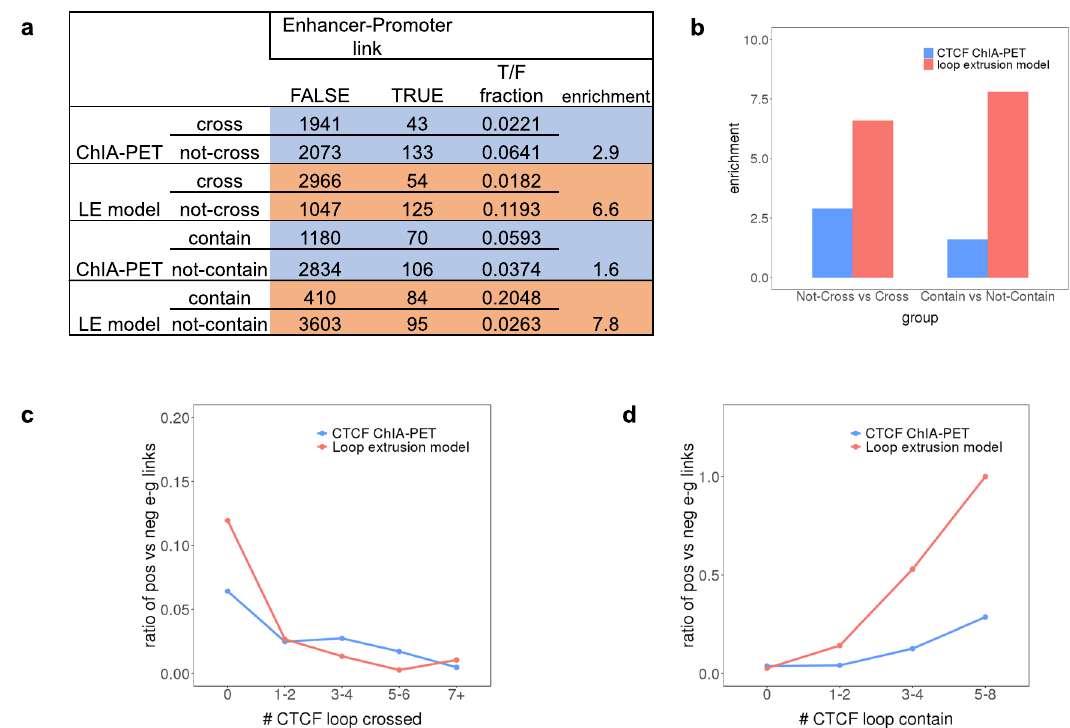
Fig. 8 CTCF loops are predicted to constrain enhancer – promoter interactions, but loop extrusion model predicted loops do so more accurately. a Counts of true (interacting) and false (non-interacting) enhancer – promoter (E – P) pairs according to whether they cross, or are contained within CTCF loops. Ratios of true and false E – P links are also shown (T/F). b Enrichment of T/F ratio between each group are calculated and compared between CTCF ChIA-PET annotated loops and loops predicted by our loop extrusion model. Strikingly, the predicted CTCF loops are much more enriched for loops which contain (and do not cross) E – P interacting pairs. c T/F ratio against the number of CTCF loops each E – P link crosses is plotted. d T/F ratio against the number of CTCF loops containing each E – P link is